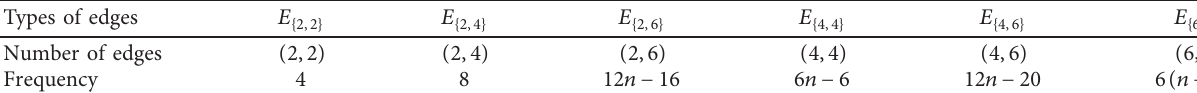
Figure 2: Star of David network. Table 1: Star of David network edge